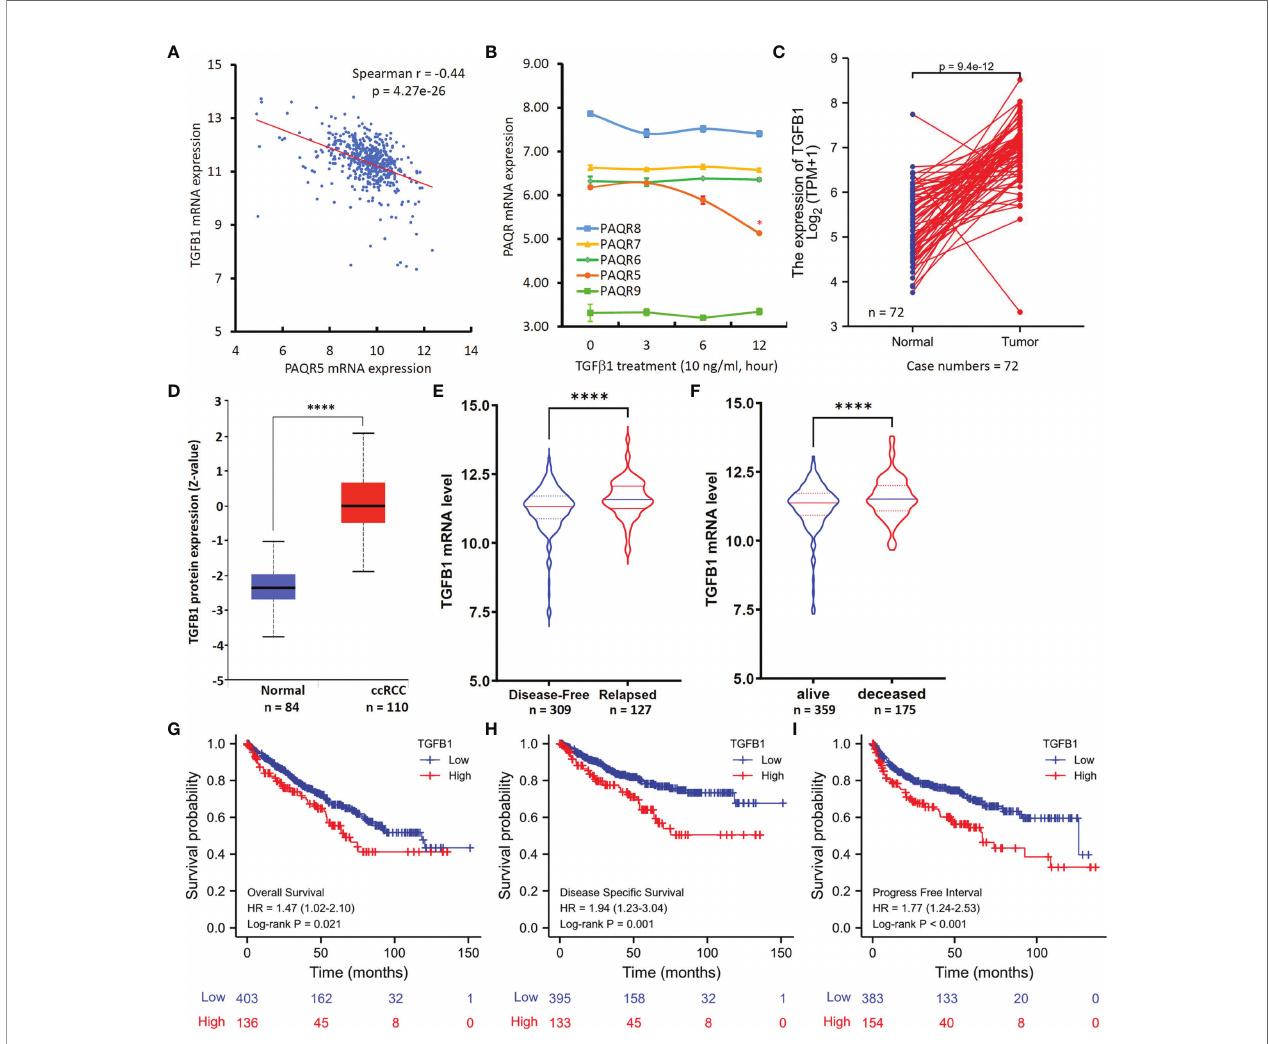
FIGURE 5 | TGFB1 expression inversely correlates with PAQR5 expression in ccRCC tissues. (A) Spearman coef fi cient analysis was conducted using the TCGA-Firehose Legacy RNAseq dataset downloaded from the cBioportal platform (case number = 534). The mRNA levels were presented as log 2 (RSEM+1) values. RSEM: RNA-Seq by Expectation-Maximization. (B) Human IOSE cells were treated with TGF b 1 (10 ng/ml) for the indicated time-period. Total RNAs were extracted for gene expression analysis on the Affymetrix Human Genome U133A plus 2.0 GeneChip. The error bar represents the SEM of the mean. The asterisk indicates a signi fi cant difference compared to the 0-h control (Student t -test, p < 0.05). (C) TGFB1 expression levels between case-match pairs of normal kidneys and ccRCC tissues in the TCGA dataset. The p-value was derived from Wilcoxon signed-rank test. (D) TGF b 1 protein level in ccRCC and normal kidney tissues using the CPTAC dataset (22). The Quadro-asterisk indicates a signi fi cant difference (unpaired t -test, p < 0.0001). (E, F) TGFB1 expression levels were compared between disease-free vs. relapsed or alive vs. deceased patients using the TCGA-Firehose Legacy RNAseq dataset downloaded from the cBioportal platform. The Quadro-asterisk indicates a signi fi cant difference (unpaired t -test, p < 0.0001). (G – I) Kaplan-Meier curve analysis was conducted for overall and disease-speci fi c survival, as well as the progression-free interval in ccRCC patients based on TGFB1 expression using the TCGA dataset with a minimum p-value approach